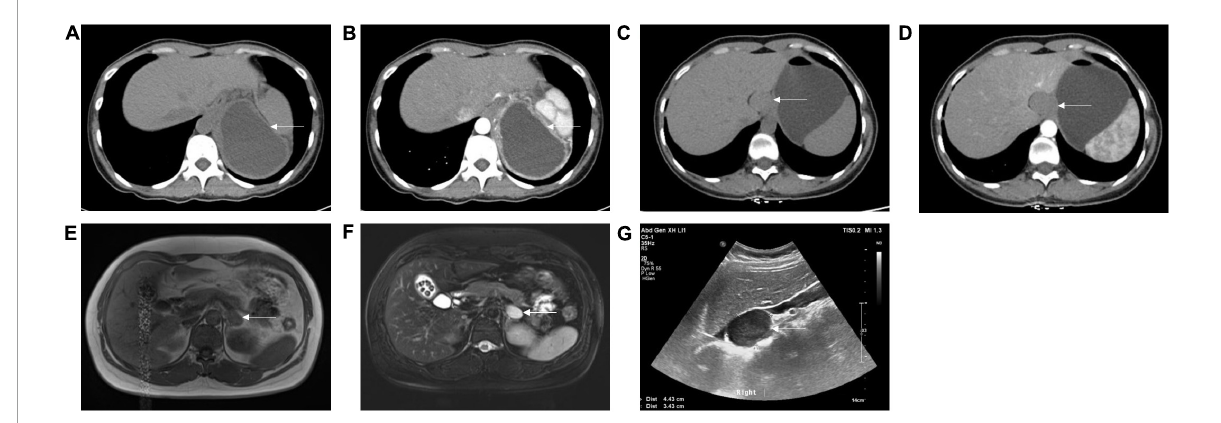
FIGURE1 Appearance of subdiaphragmatic bronchogenic cysts on computed tomography (CT), magnetic resonance imaging (MRI), and B ultrasound. (A) Non-enhanced CT showed a low-density cystic lesion between the pancreatic tail, stomach, spleen, and diaphragm from case 13. (B) Enhanced CT showed slight enhancement of the cystic wall from case 13. (C) Non-enhanced CT showed a soft-tissue density lesion adjacent to the lesser curvature of the stomach from case 19. (D) Enhanced CT showed no enhancement of the lesion from case 19. (E) T1 weighted image on MRI showed a hypointense lesion at the left adrenal region from case 16. (F) T2 weighted image on MRI showed a hyperintense lesion at the left adrenal region from case 16. (G) B ultrasound showed a well-defined, hypoechoic lesion at the right adrenal region from case 17. Arrows indicate the